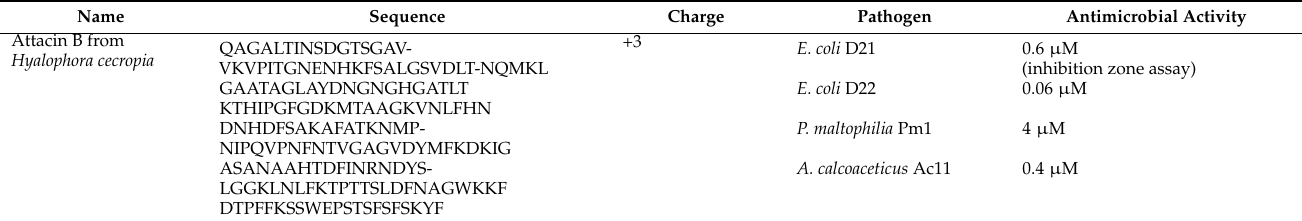
Table 1. Attacins mature sequences (N-terminal, G1 and G2 domains) and antimicrobial